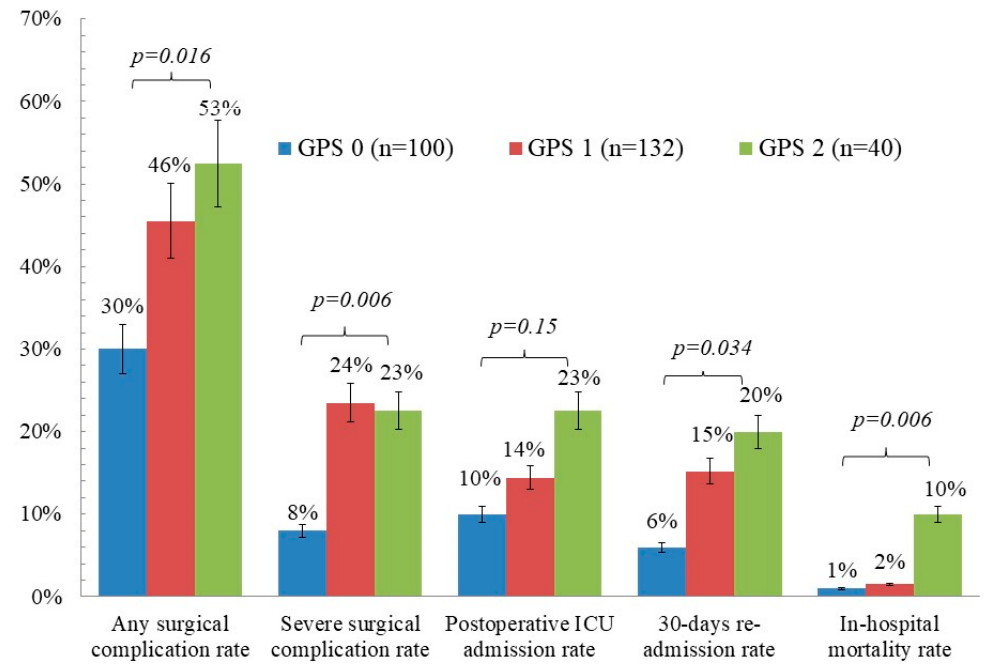
Figure 1. Prevalence rate of short-term postoperative complications according to Glasgow prognostic score (GPS). ICU, intensive care unit. J. Clin. Med. 2019 , 8 , x FOR PEER REVIEW